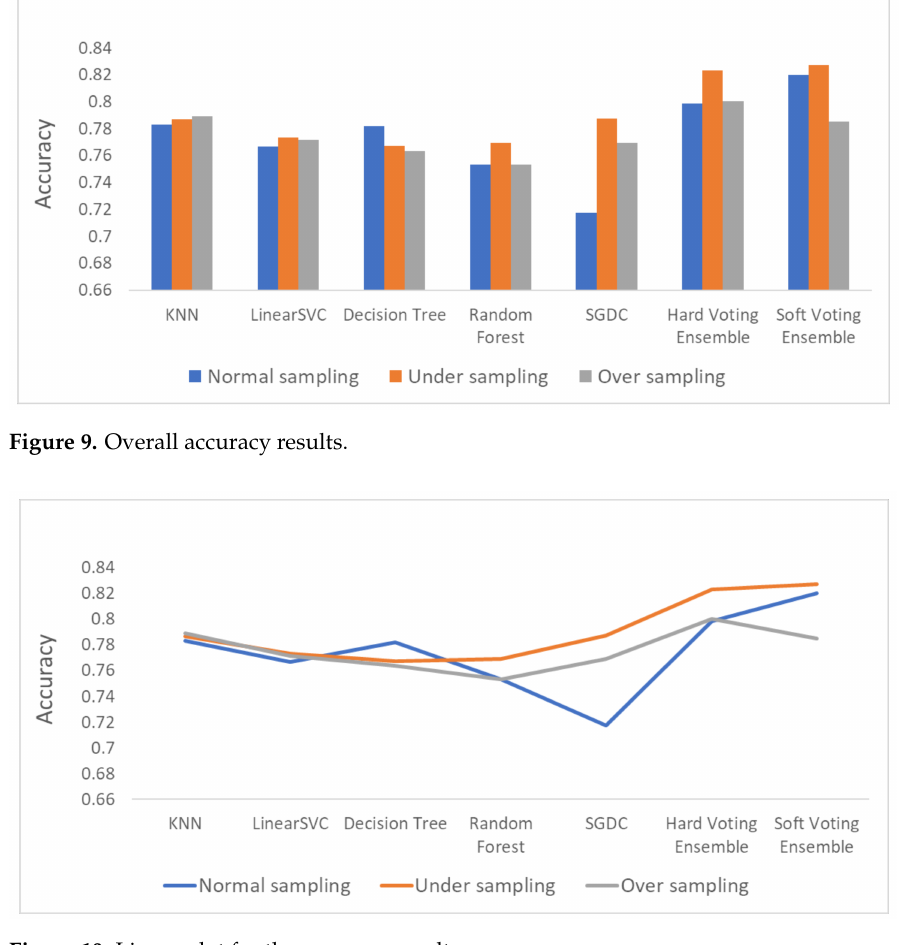
Figure 10. Linear plot for the accuracy